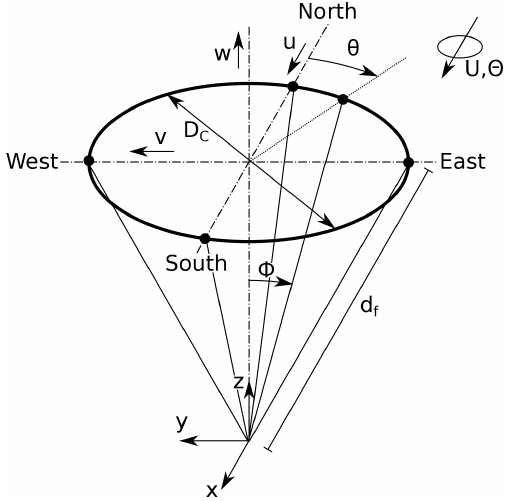
Figure 1. Lidar geometry definitions and coordinate